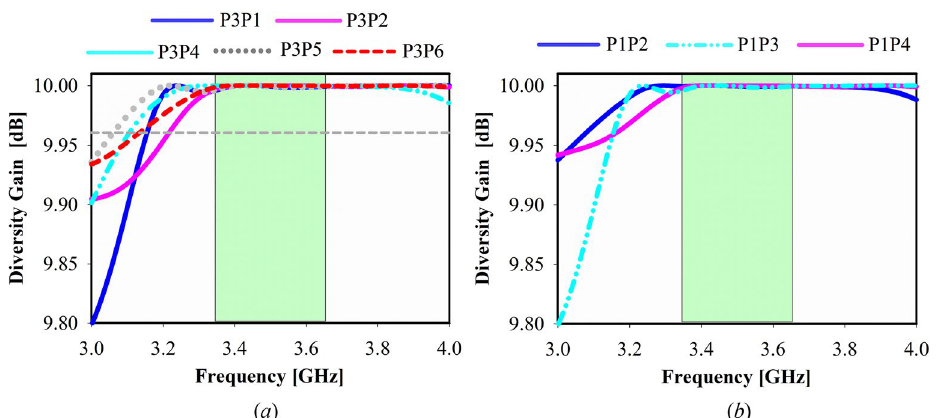
Figure 16. Diversity gain of the suggested mMIMO antenna, ( a ) Port 1, 2, 3, 4, 5, 6, ( b ) Prot 1, 2, 3,